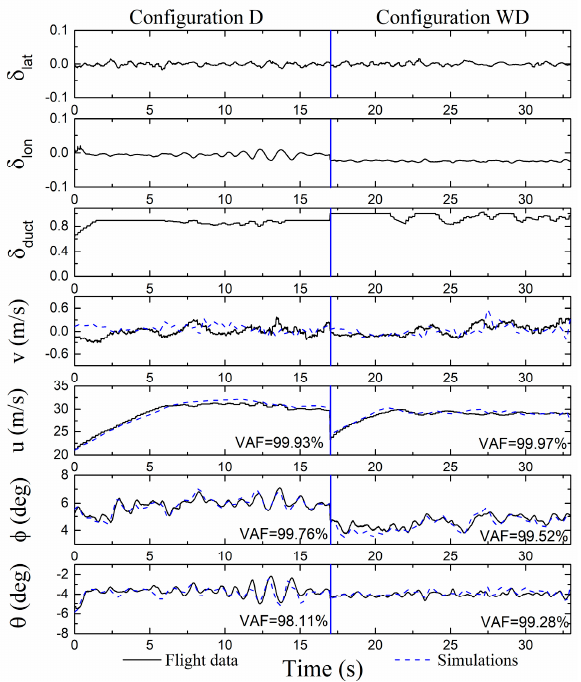
Figure 12. Time-domain validation in forward flights under Configuration D and Configuration WD.